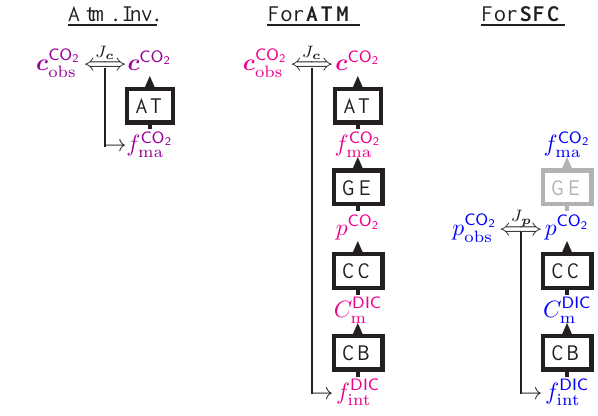
Fig. 2. Illustration of the inverse procedure (three modi). Boxes de- note the process parameterizations from Figure 1, causally linking quantities from bottom to top. Double arrows symbolize the match- ing between observed and modelled quantities, as gauged by a cost function J (Appendix A2). Thin arrows indicate the adjustments of the respective unknowns done to minimize the model-data mis- match. Left: Pure atmospheric transport inversion not used here but given for reference: The sea-air fluxes f CO 2 ma are adjusted to match atmospheric mixing ratios (terrestrial Net Ecosystem Exchange is adjusted as well but omitted from this schematic for clarity). Mid- dle: In case ATM , ocean-internal sources/sinks f DIC int are adjusted instead of sea-air fluxes to match atmospheric CO 2 mixing ratios (again Net Ecosystem Exchange is further adjusted). Right: In case SFC , ocean-internal sources/sinks are adjusted to match the surface-ocean CO 2 partial pressure observations. Sea-air fluxes are then calculated from the estimated partial pressure field.